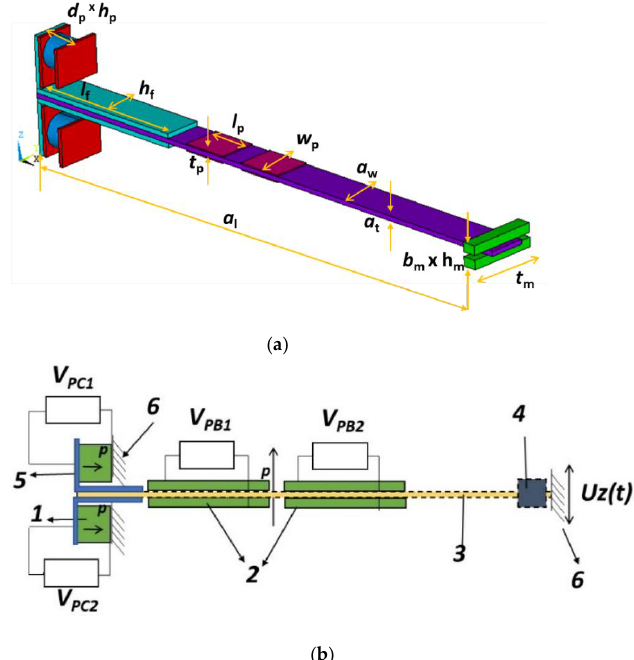
Figure 1. Design of piezoelectric energy harvester: ( a ) schematic diagram and, ( b ) various elements. Table 1. Geometric dimensions of energy harvester elements.